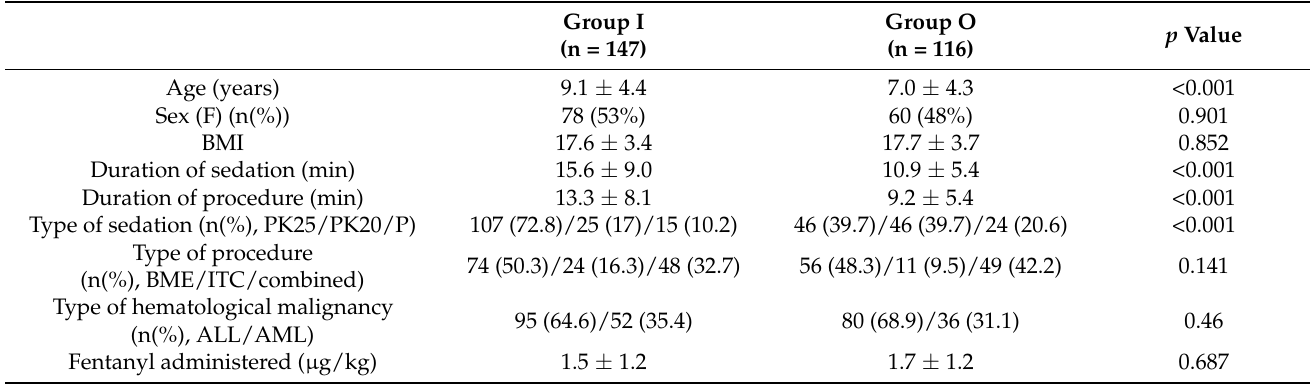
Table 2. Patient characteristics.